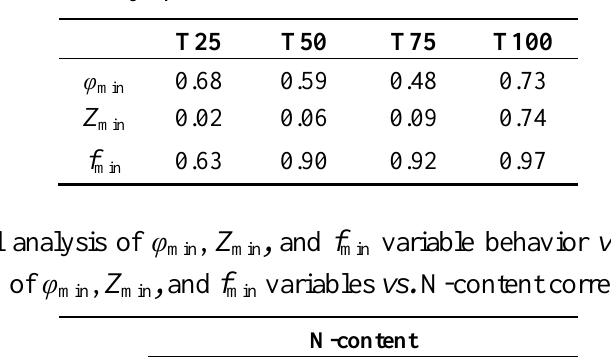
Table 4. Statistical analysis of φ ANOVA p -values between days per treatment.